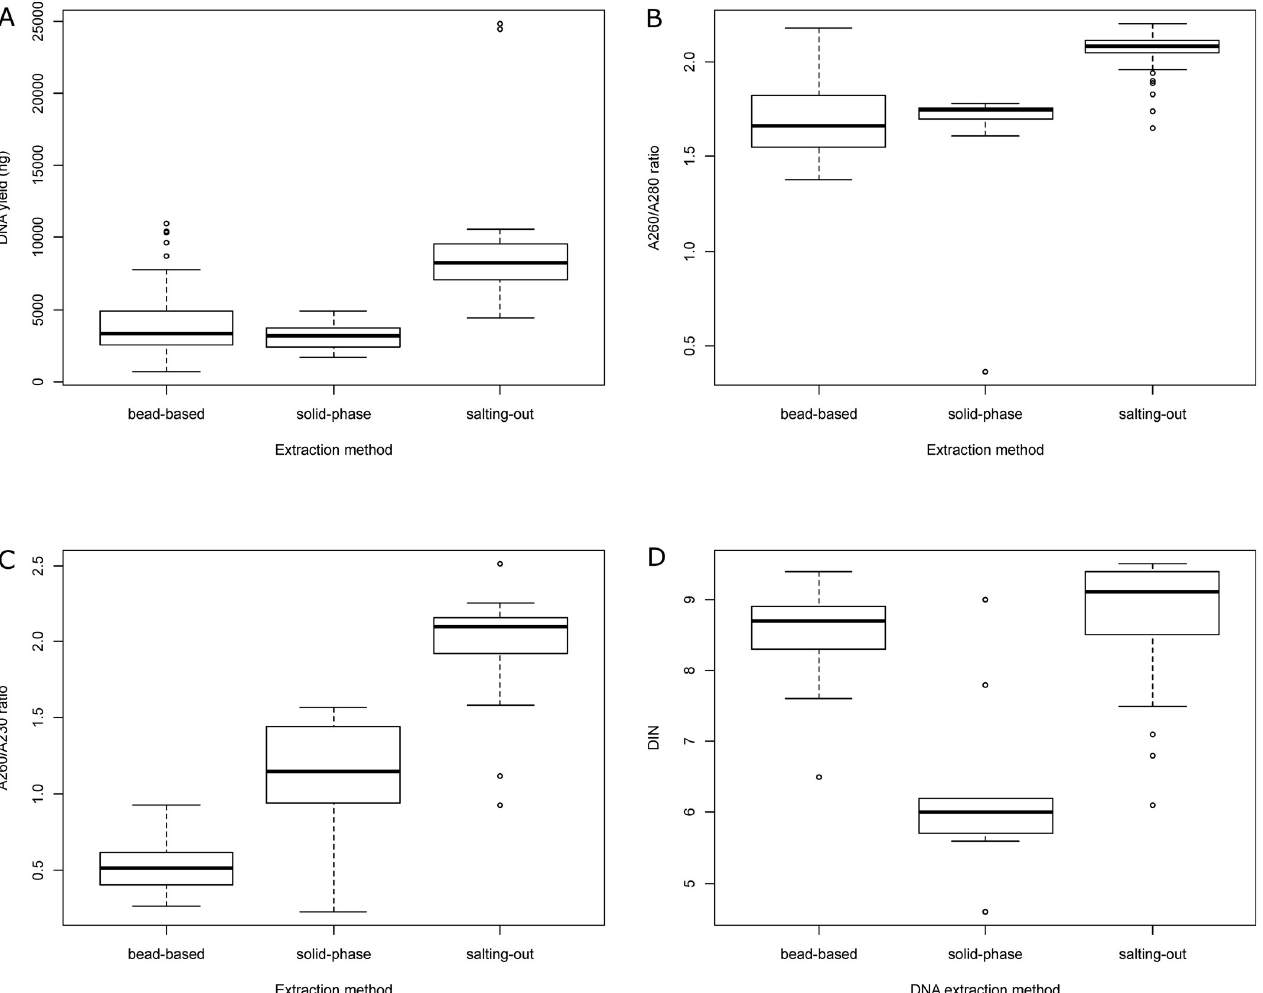
Fig 2. Quantity and quality of the extracted DNA according to the DNA extraction method. (A) DNA yield (ng.mL -1 culture) as determined with Qubit dsDNA Broad range assay kit, (B) A260/A280 ratio as determined with Nanodrop, (C) A260/A230 ratio as determined with nanodrop, (D) DIN value as determined with Genomic DNA